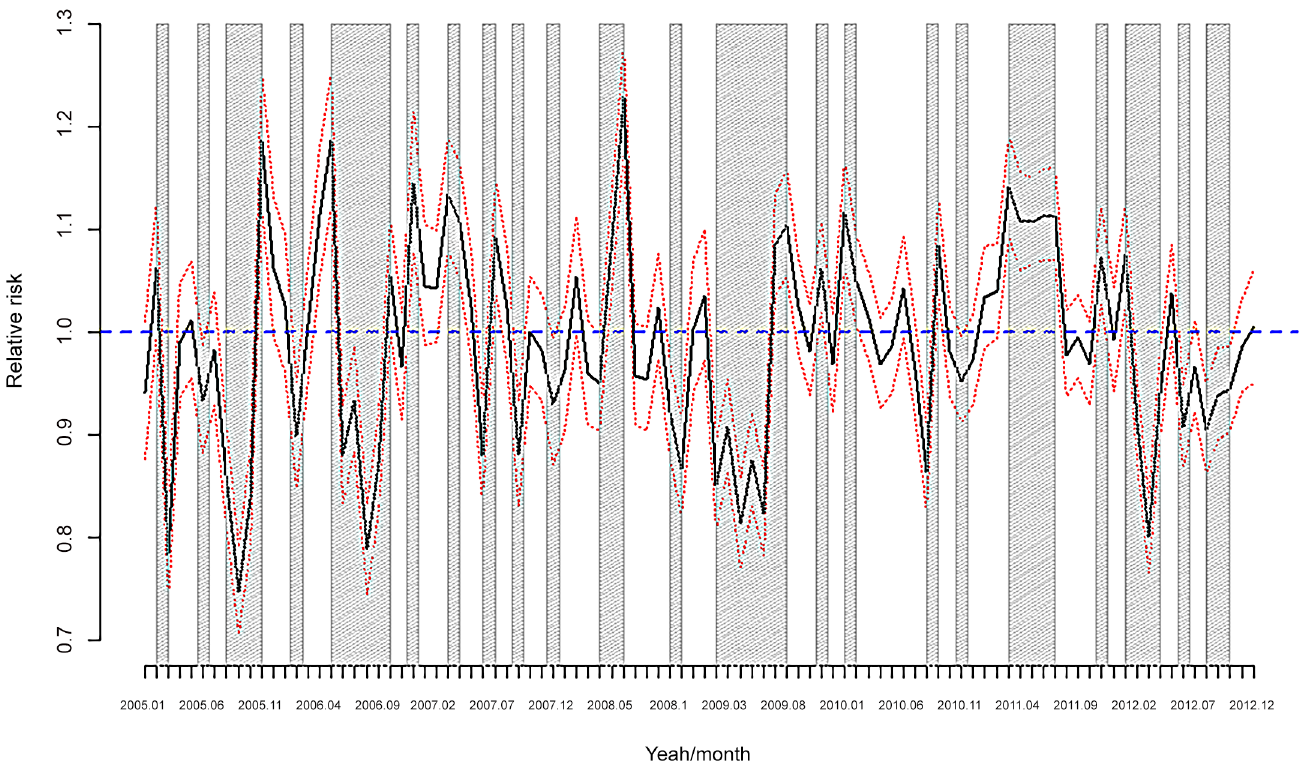
Fig 6. DDD per individual/month. Monthly data for the period 2005 – 2012. Shaded Statistically significant (the 95% credibility interval does not contain the unit).